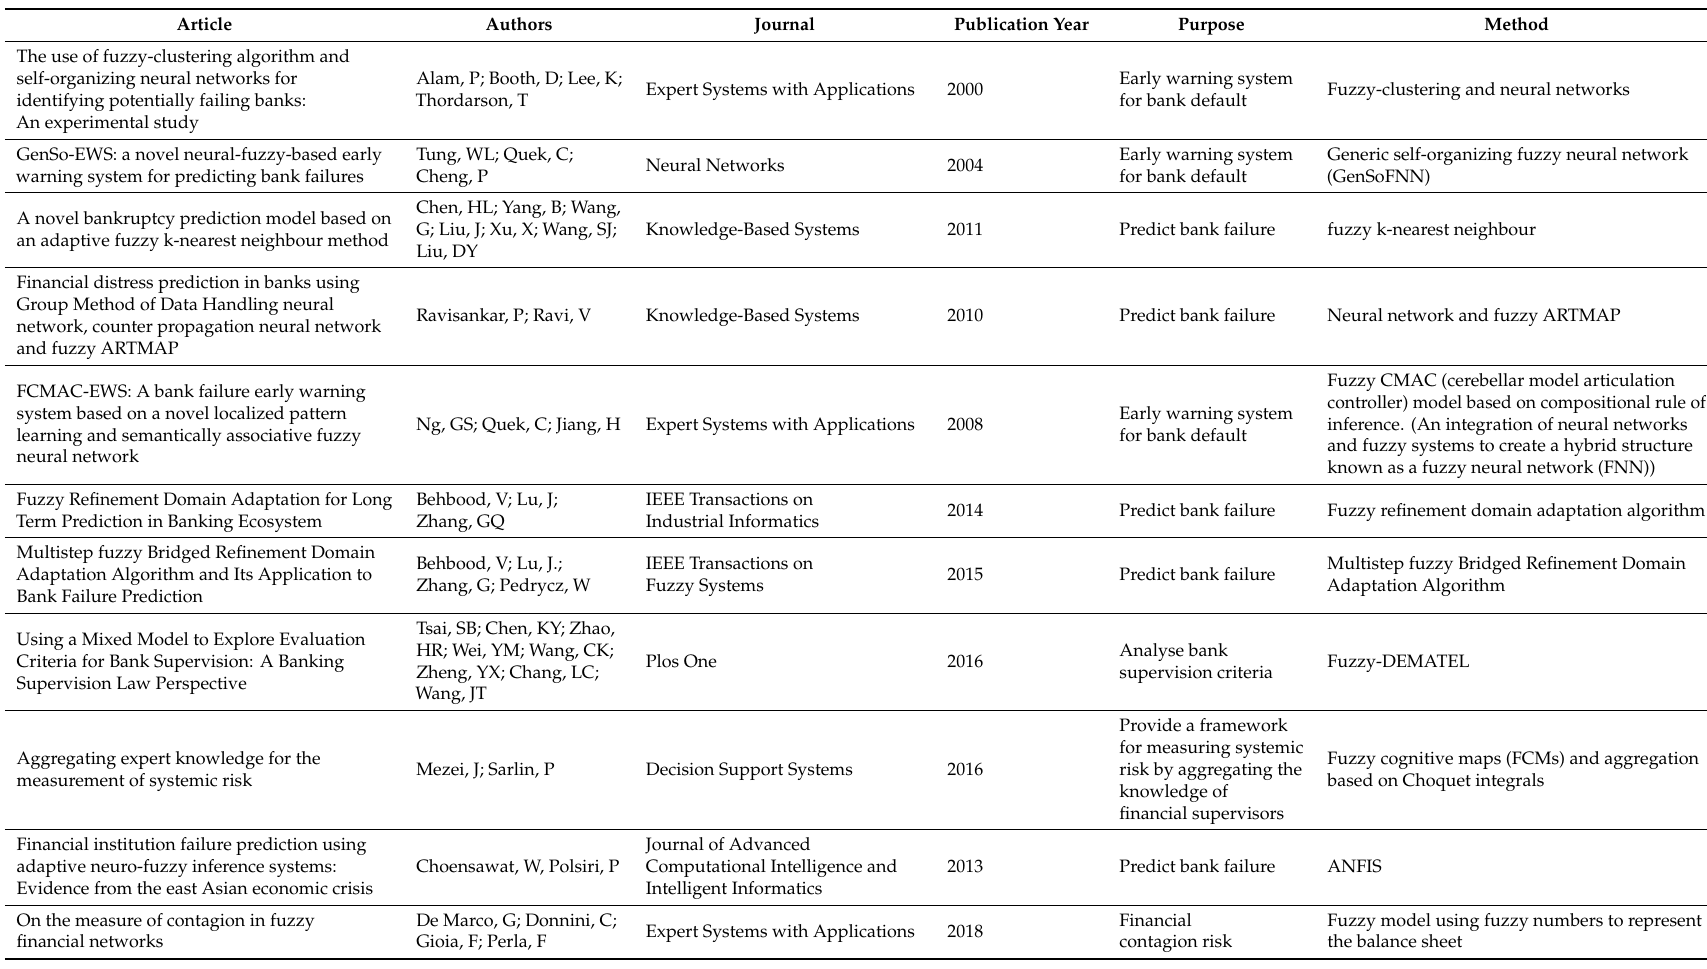
Table A2. Fuzzy logic in banking